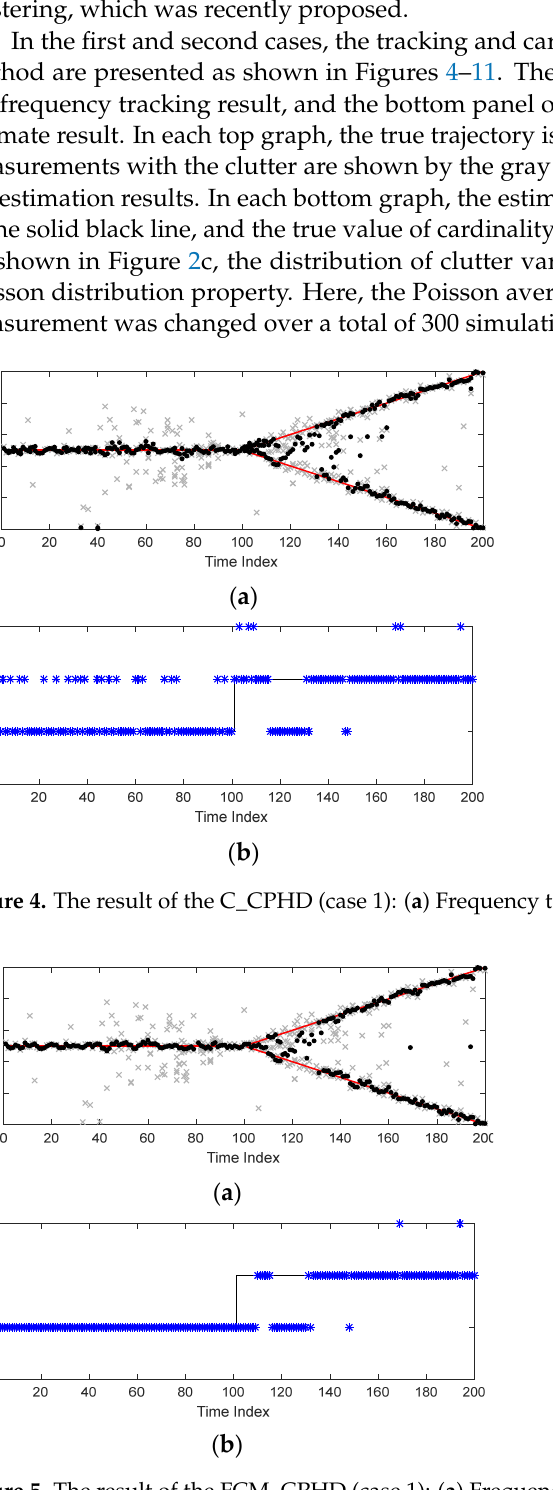
Figure 5. The result of the FCM_CPHD (case 1): ( a ) Frequency tracking; ( b ) Cardinality estimate.